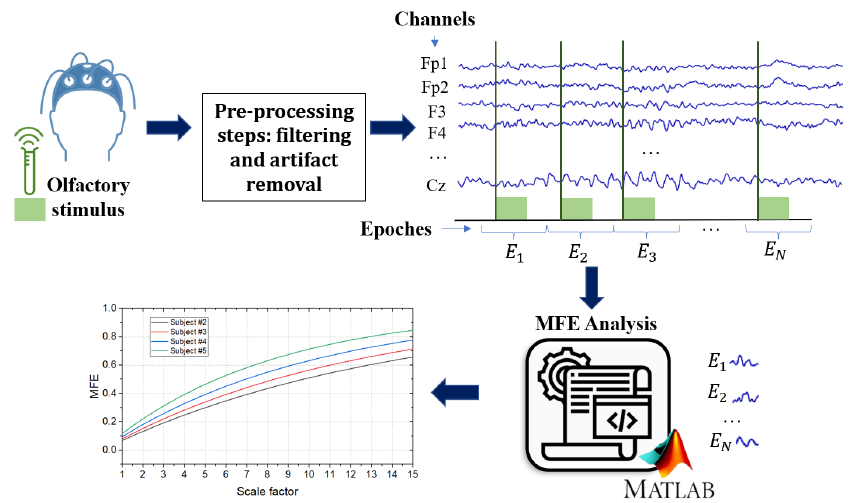
Figure 2. General layout of the proposed approach. The EEG signals are acquired from the subject during an olfactory stimulation task. The acquired signals are filtered with a bandpass filter and an artifact removal technique is performed to remove artifacts. The MFE algorithm was applied to each epoch for each